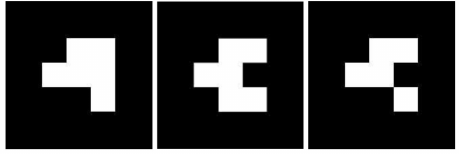
Figure 23. 2D BARCODE markers.